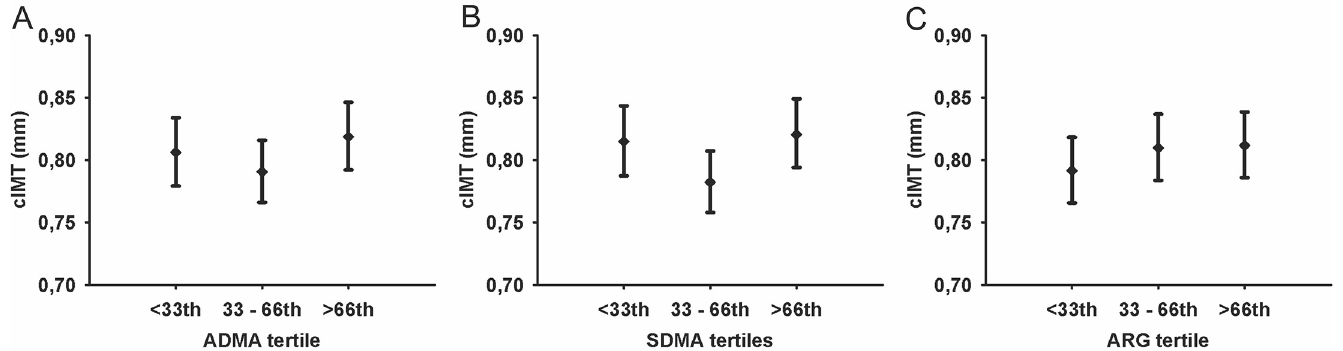
Fig 1. Estimated mean of cIMT with 95%-CI by ADMA (A), SDMA (B), and ARG (C). Multivariate analyses of variance were adjusted for age, sex, WHR, smoking, physical activity and eGFR. Post hoc comparison adjusted for multiple testing using Tukey. # P < 0.10 in post-hoc comparison. (cIMT indicates carotid intima-media thickness; ADMA, asymmetric dimethylarginine; SDMA, symmetric dimethylarginine; ARG, L -Arginine).